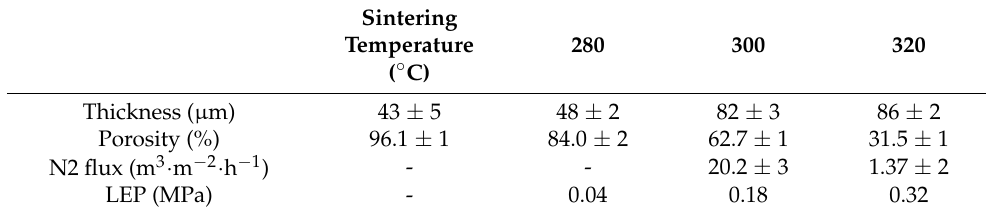
Table 3. The characteristics of the ultrafine fibrous FEP porous membranes.